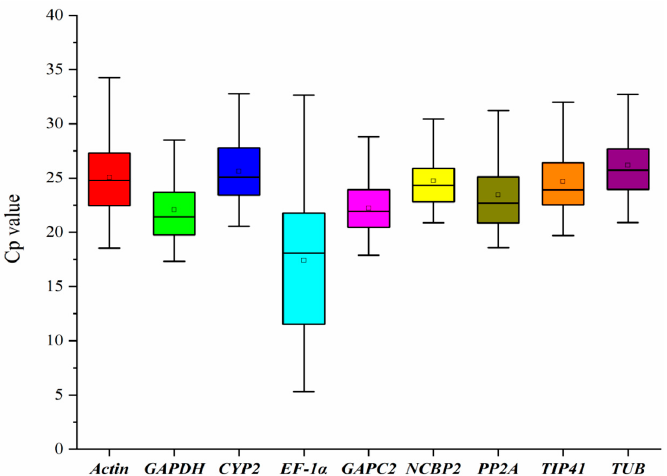
Figure 1. Distribution of cycle threshold values (Cp) of nine candidate reference genes. The expression data are demonstrated as Cp values for individual genes in samples of P. somniferum. The box graph shows the range of 25th to 75th percentile. The line across the box represents the median and the square in the box indicates the mean. The whiskers show the maximum and minimum